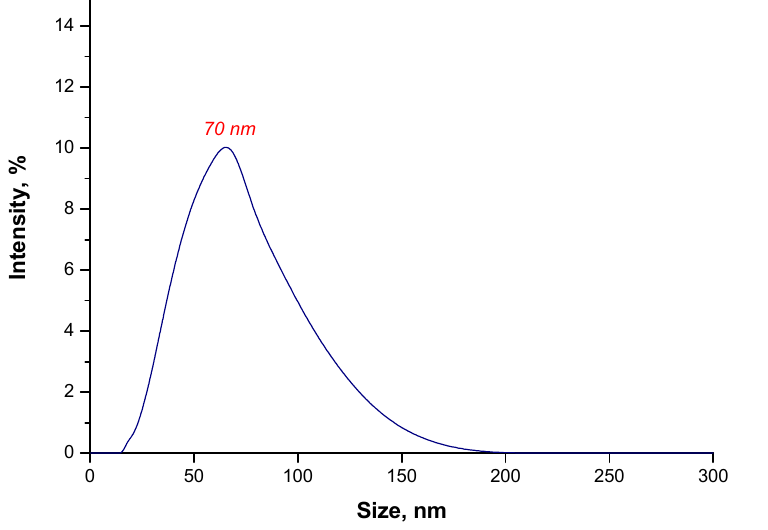
Figure 8. The size analysis of Fe 3 O 4 @Au particles obtained in the oil and water environment after 15 min sonication.